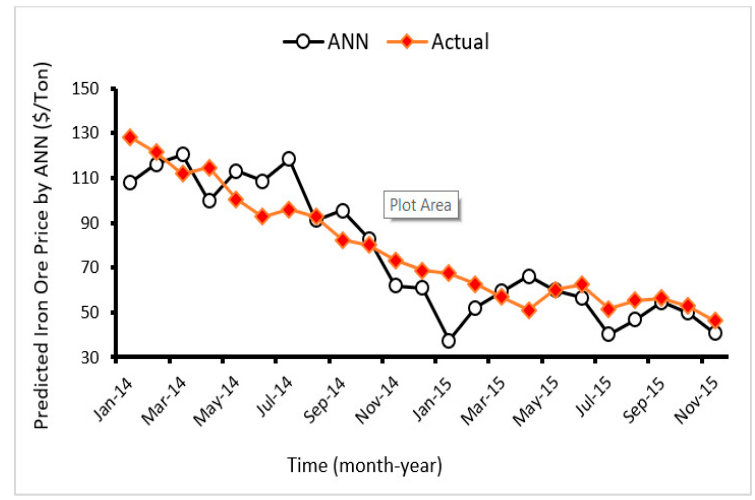
Figure 12. Comparison between the measured and the predicted by ANN model for test stage. Appl. Sci. 2020 , 10 , x FOR PEER REVIEW